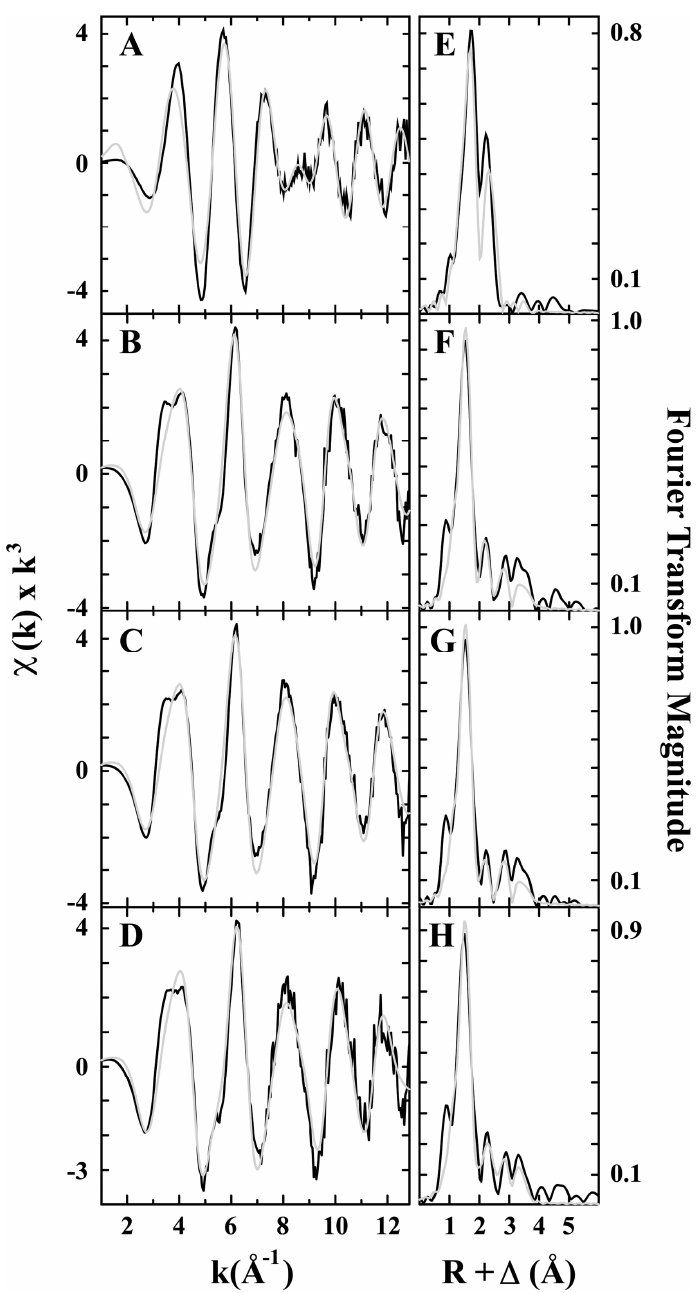
Figure 2. Cu EXAFS fitting analysis for pMMO. Raw data for ( A ) reduced, ( B ) as-isolated, ( C ) Cu-reconstituted, and ( D ) oxidized. The phase-shifted Fourier transform- for ( E ) reduced, ( F ) as-isolated, ( G ) Cu-reconstituted, and ( H ) oxidized. Black spectra are raw EXAFS data and gray spectra are the fitted simulations. Reproduced with permission from ref. [36]. Copyright 2011, American Chemical Society.